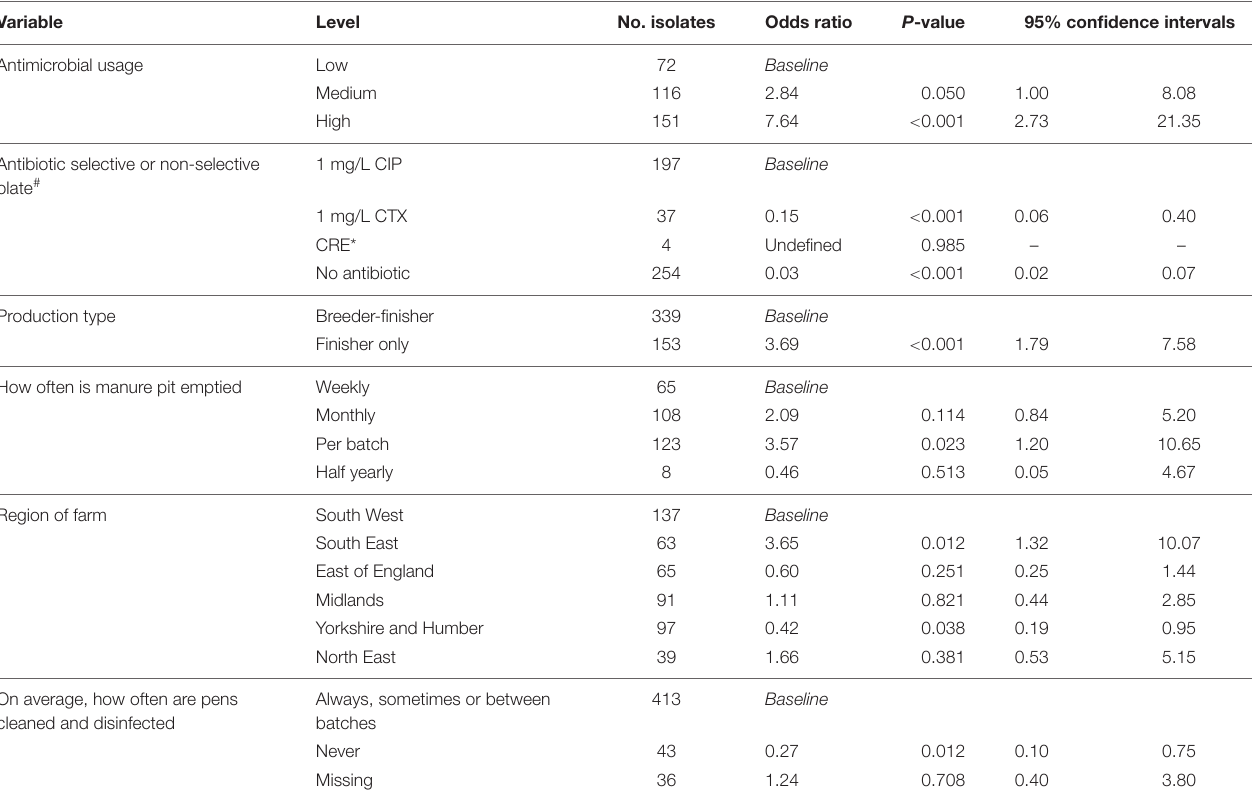
TABLE 3 | Multivariable risk factor analysis, assessing for the association between genotypic multi-drug resistance and variables of interest ( n = 492, of which 296 were multi-drug resistant). Variable Antimicrobial